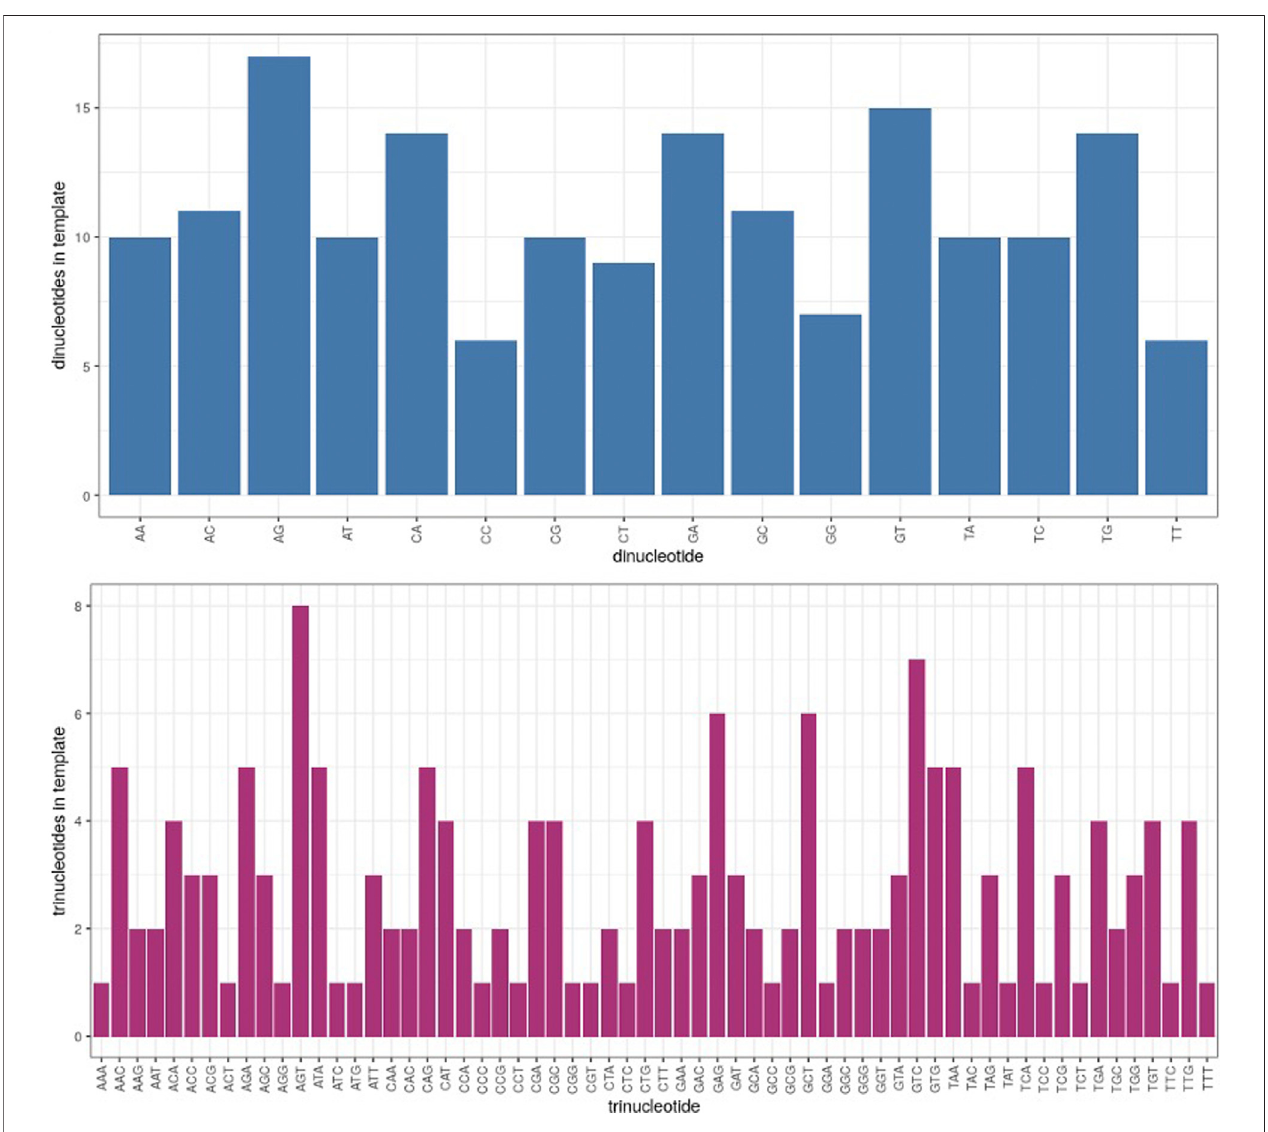
FIGURE7| Distributionofdinucleotides (blue) and trinucleotides(magenta) intemplate strand,listed in alphabetical order according tothenucleotidepairs ( ie. AA, AC,AGetc.andAAA,AAC,AAGetc.).The Y axisrepresentsthenumberoftimesagivendi-ortrinucleotideoccurredinthe175 bptemplateregionwhichwasanalyzed.